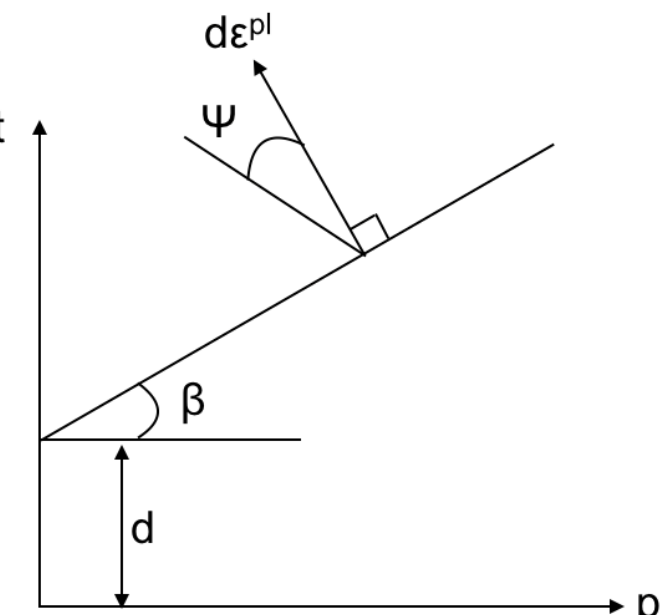
Figure 1. Schematic diagram of the effective stress t vs. the hydrostatic pressure p for the linear DP constitutive model. The parameter β represents the slope of the t - p line, d is the intercept at p = 0 and ψ is the dilation